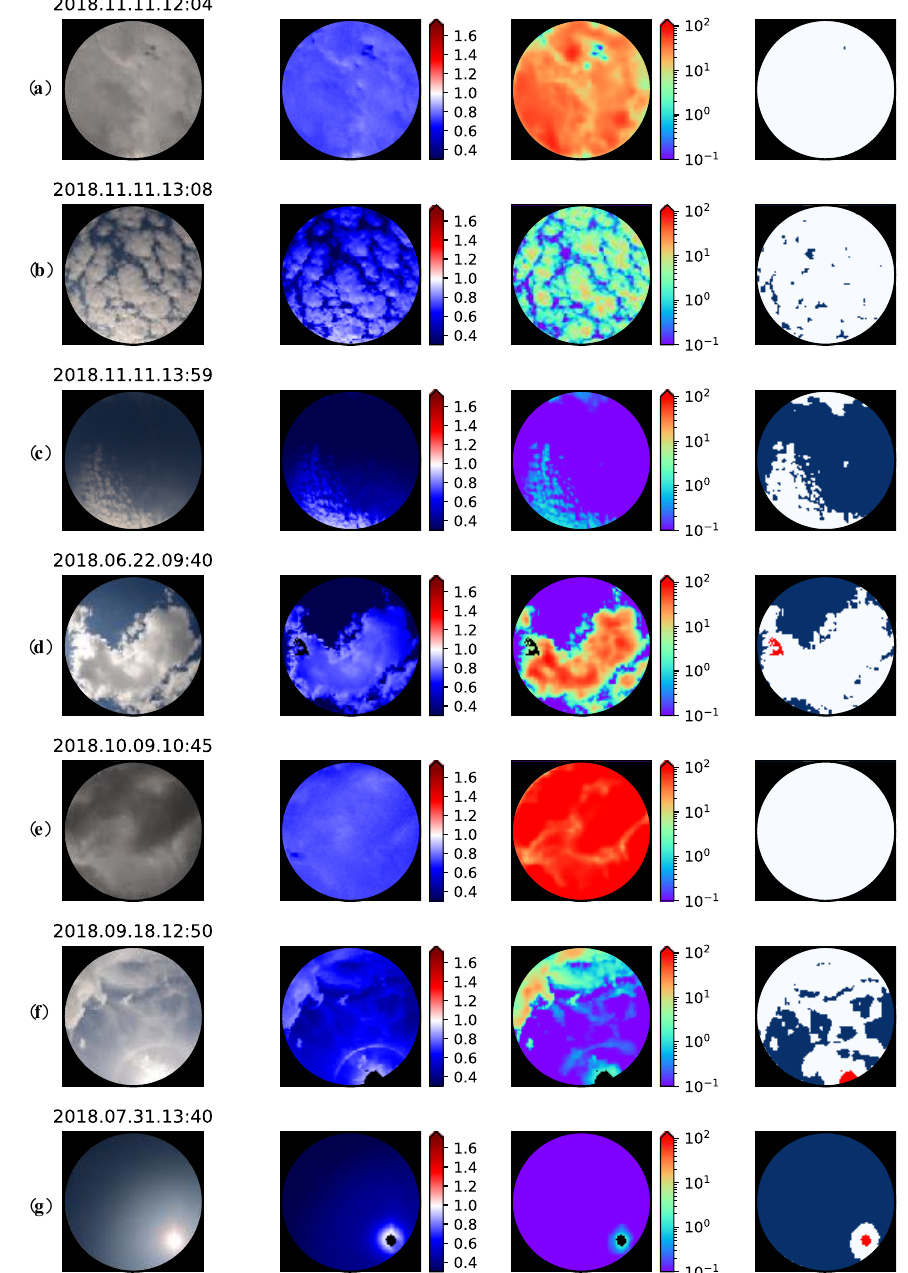
Figure 13. Examples of SCOT estimated from a ground-based zenith-oriented digital camera. Cases ( a – g ) correspond to single snapshots made at respective times shown in the title of the leftmost panel. The observation time is shown in the YYYY.MM.DD.HH:XX format, where YYYY denotes the year, MM the month, DD the day, HH the hour, and XX the minute. The columns from left to right show the camera images in JPEG format, the RBR, the estimated SCOT, and the cloud flag, respectively. The cloud flag is displayed with a white color for cloudy pixels, a navy-blue color for clear-sky pixels, and a red color for the pixels that are undetermined because of the saturation of the camera-image signals. The saturated pixels are indicated by black in the RBR and estimated SCOT images.